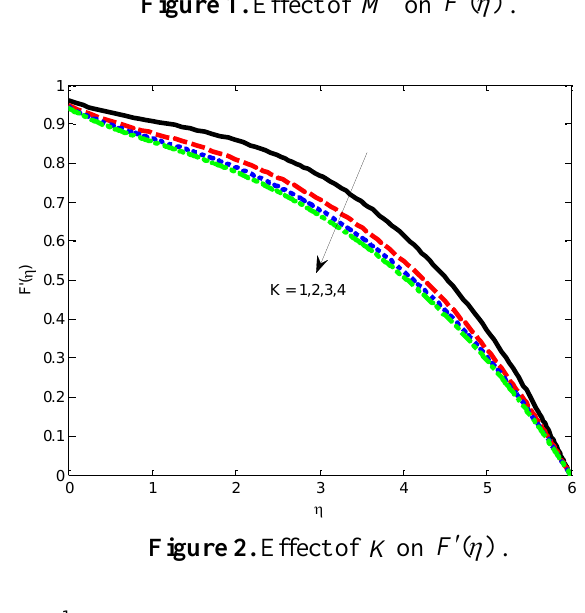
Figure 2. Effect of K on ( ) F  .